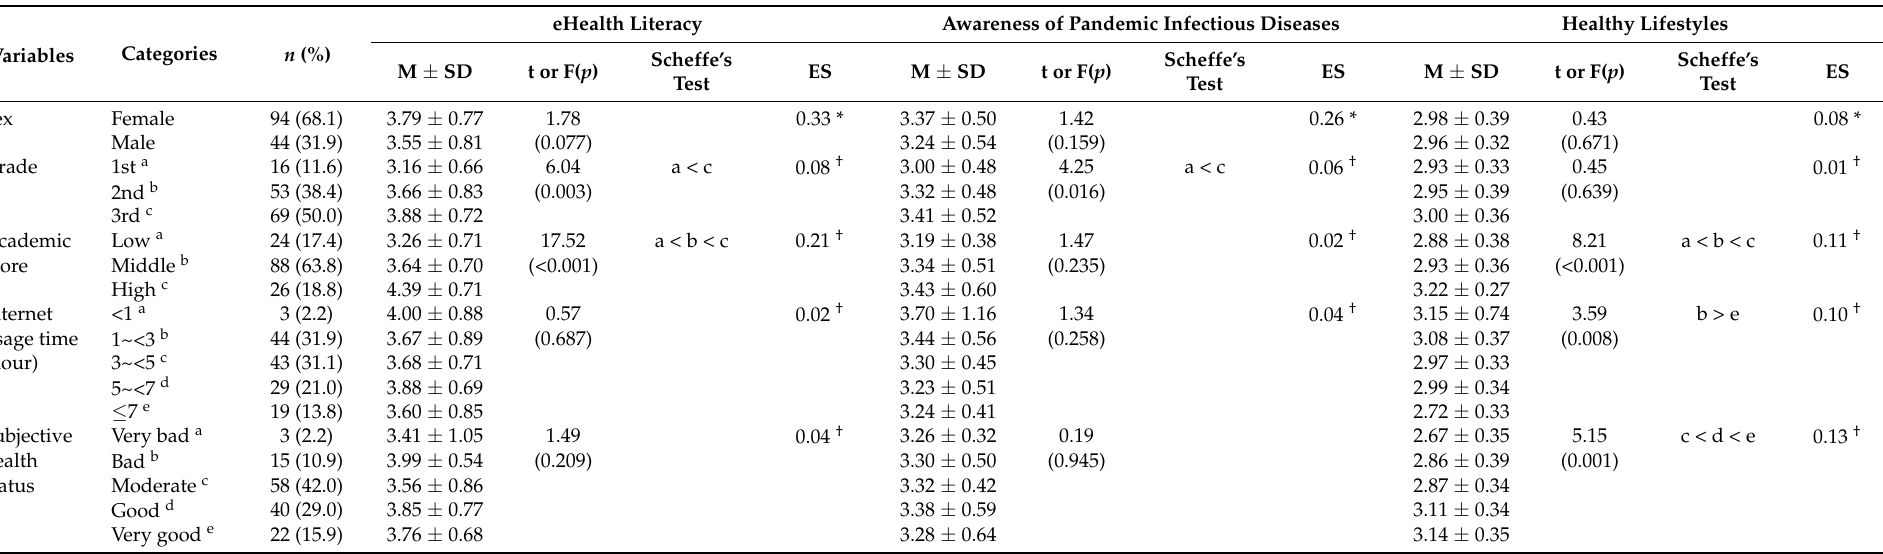
Table 1. Comparisons of eHealth literacy, awareness of pandemic infectious diseases, and healthy lifestyles according to general characteristics. ( n = 138).